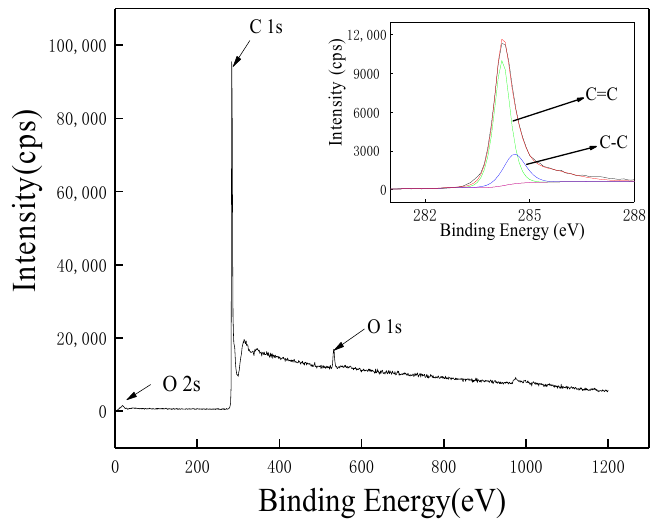
Figure 2. XPS spectra for unmodified MWCNTs. The inset shows the C1s spectra of prime MWCNTs.